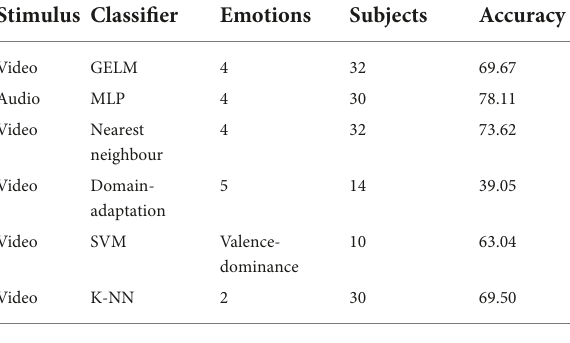
TABLE 3 Classification accuracy of deap dataset based on different recognition models.